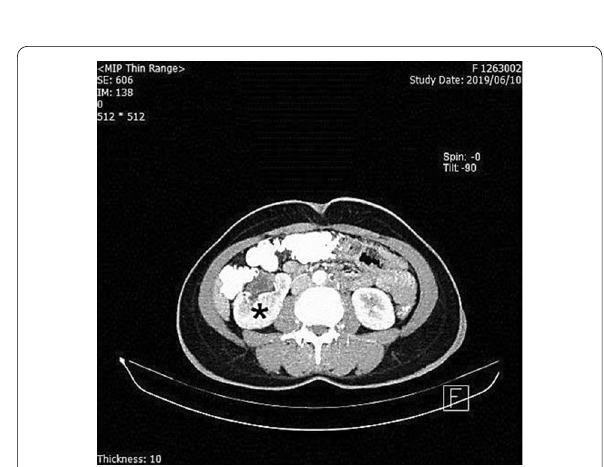
Fig. 2 Abdominopelvic CT showing malrotated right kidney (black star) and anteriorly oriented right renal